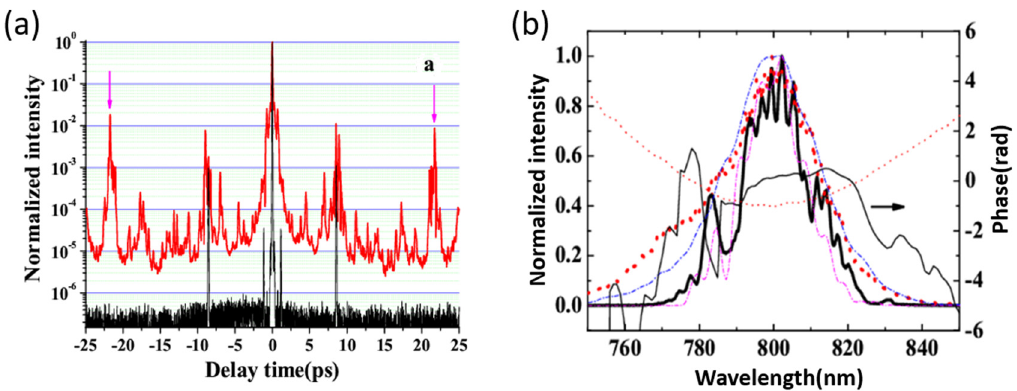
Figure 4. ( a ) Typical improvement in the temporal contrast of the reference pulse (black line) compared to that of the incident pulse (red line) during the SD process. ( b ) Typical spectrum and spectral phase of the reference pulse (red dotted lines) compared to that of the incident pulse (black solid lines) [55].